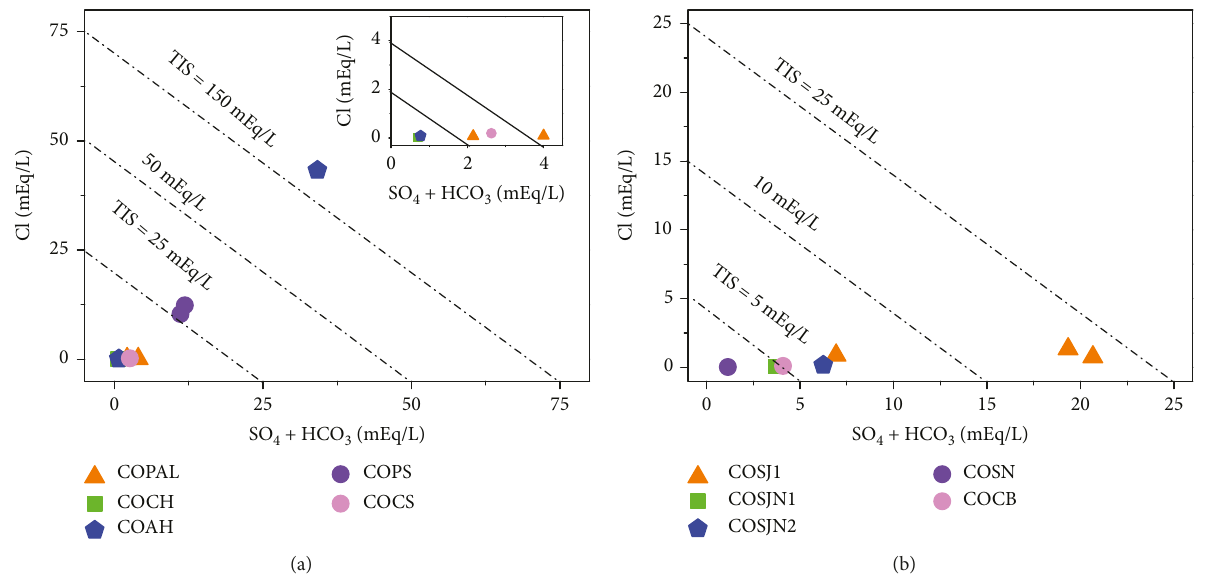
Figure 10: Total ionic salinity (TIS) lines: (a) Coconuco sector and (b) San Juan